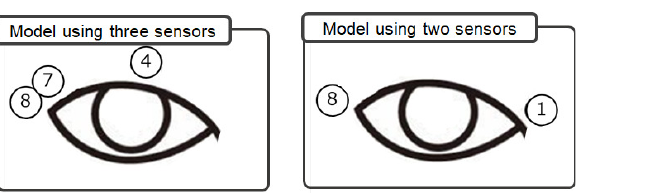
Figure 9. The sensor position with the highest recognition accuracy when the number of sensors was two or three in Evaluation